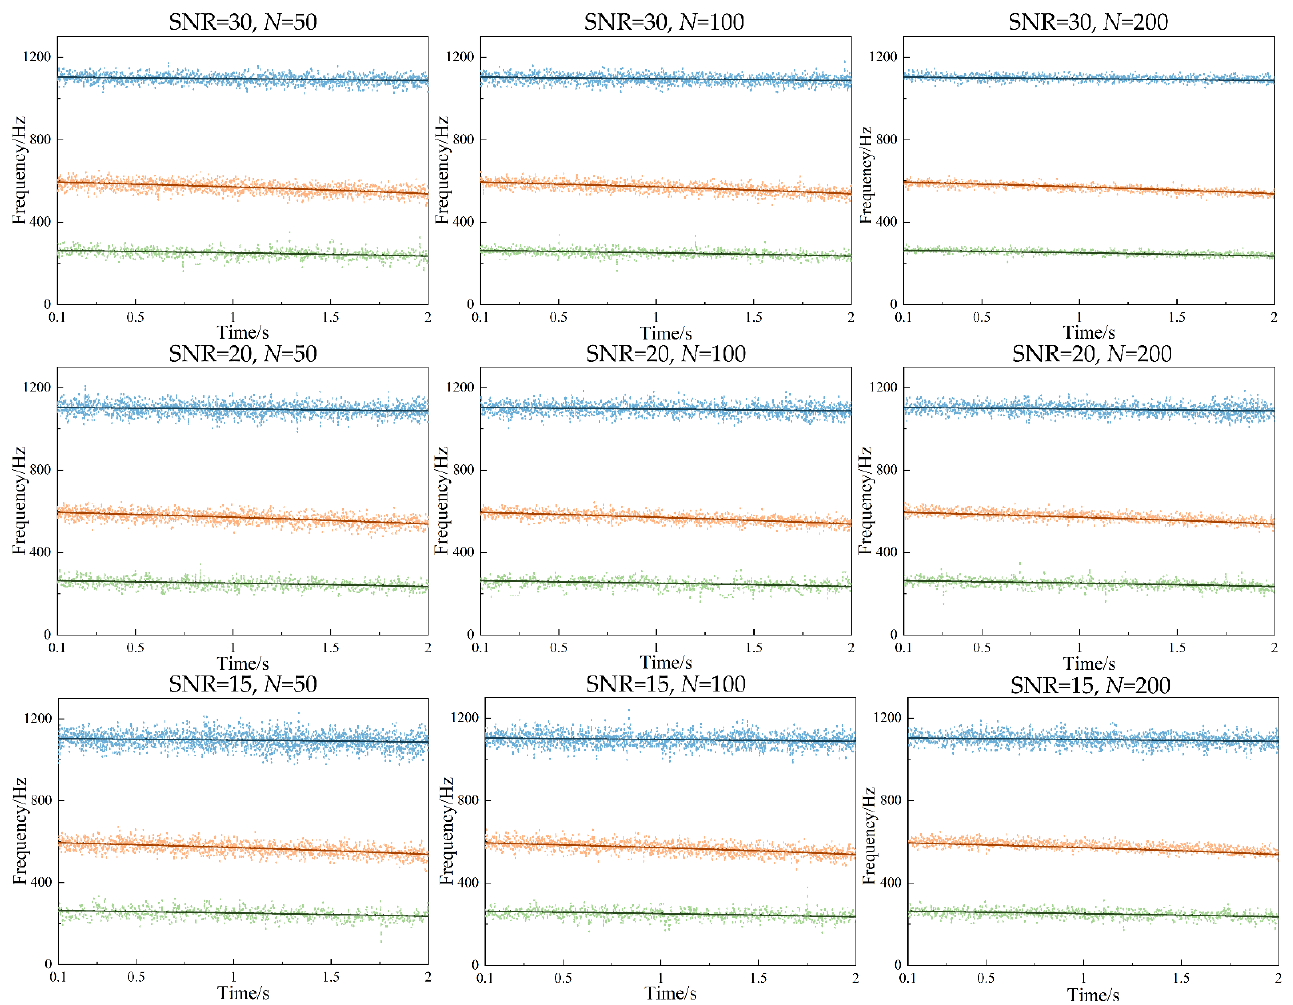
Figure 7. Natural frequencies by TARMAX under different SNR and different sliding window lengths; solid lines: estimated values; dotted lines: simulated values.